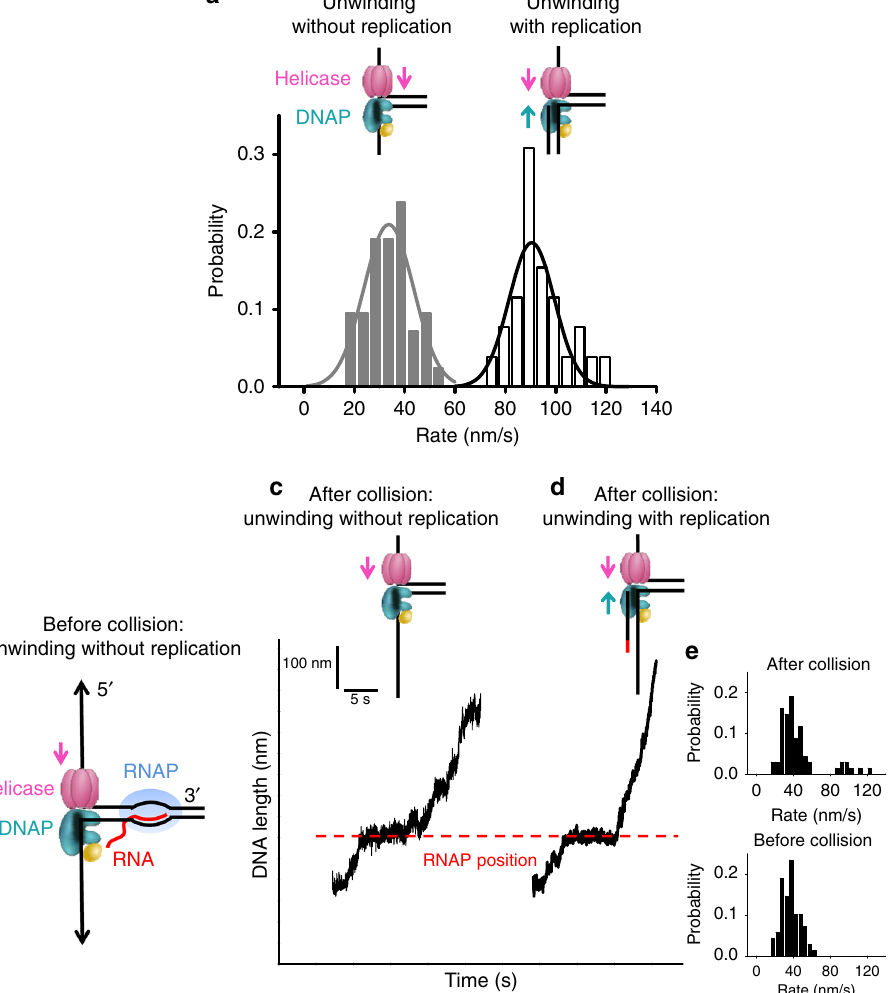
Fig. 3 Single-molecule experiments on helicase and non-replicating DNAP collision with a TEC. a Distributions of DNA length increase rates of helicase unwinding with or without replication in 0.5 mM dNTP (each) under 5 pN of force. b Experimental design. Left panel shows a cartoon of E. coli TEC that was stalled at + 20 nt from the promoter while a helicase with a non-replicating DNAP encountered the TEC co-directionally. c A representative trace of unwinding without replication after collision. Experiments were carried out in the presence of helicase, DNAP, and 0.5 mM dNTP (each) under 5 pN of force. The dotted line indicates the expected stalled TEC position. The cartoon on the top illustrates replication status after the collision with RNAP. d A representative trace of unwinding with replication after collision. Same experimental conditions were used as in c . For clarity, traces have been shifted along the time axis. e Distributions of DNA length increase rates before (upper panel) and after (lower panel) the collision with